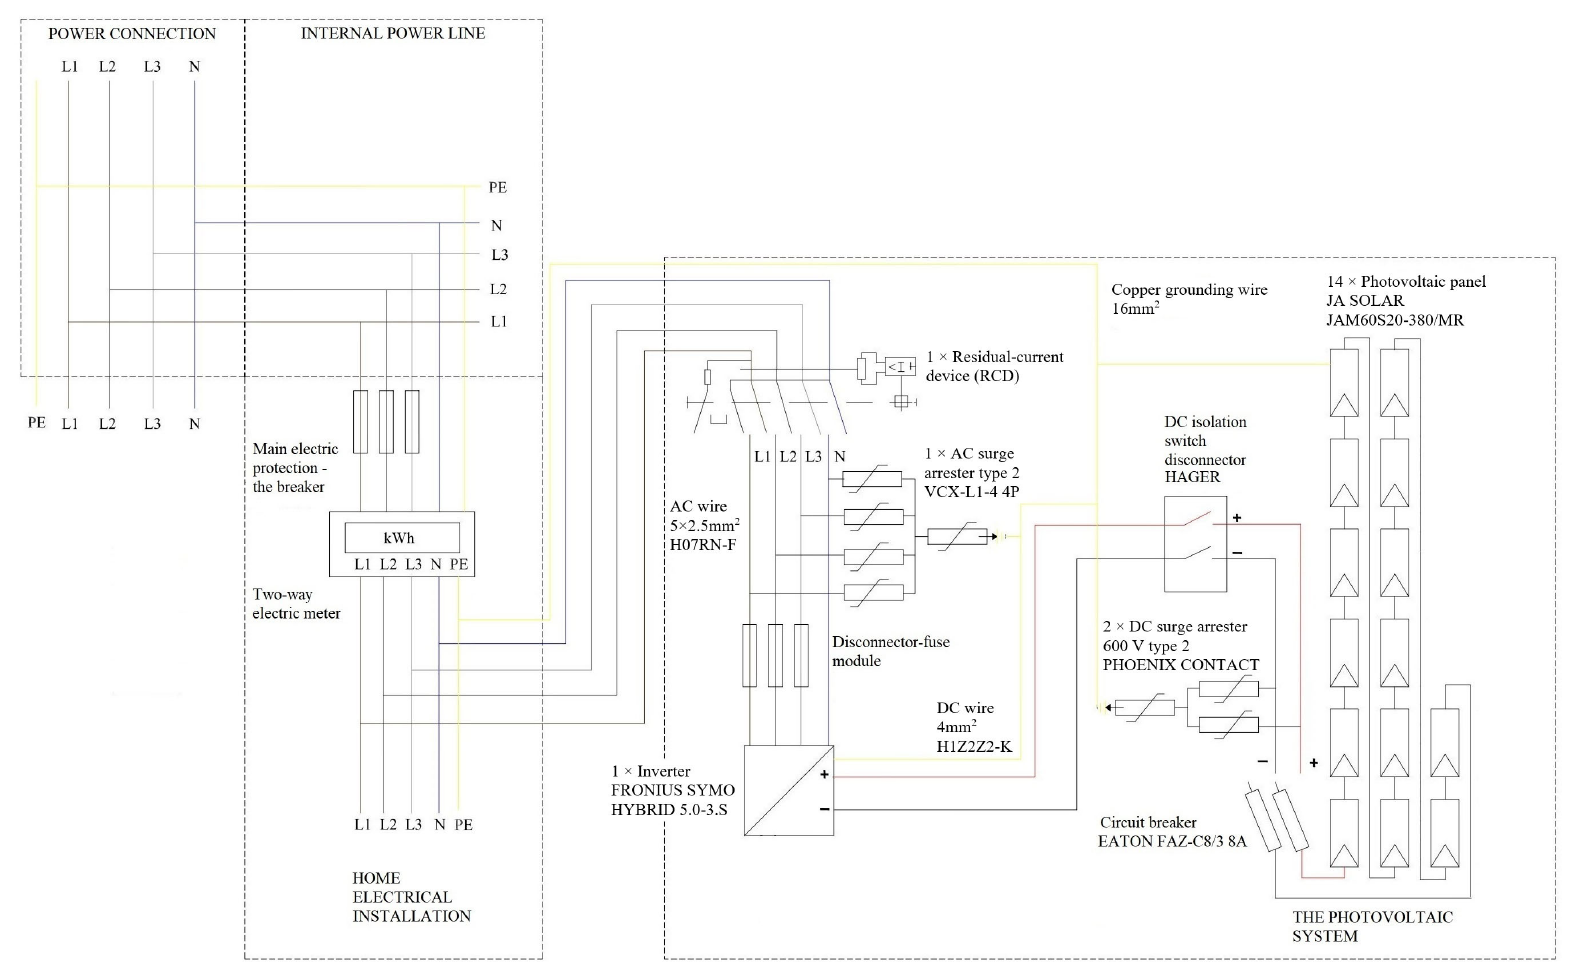
Figure A1. Electrical diagram of the designed photovoltaic installation.